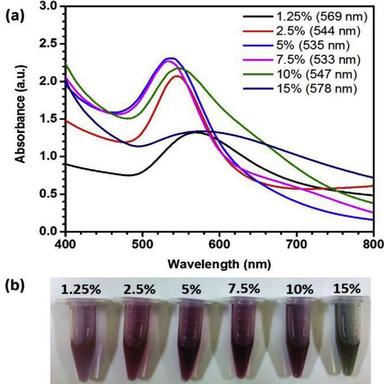
(a) UV–vis spectra of AuNPs synthesized at different concentrations of Lonicera japonica flower extract (1.25, 2.5, 5, 7.5, 10, and 15%, v/v) and (b) color changes after 2 min reaction incubation (from left to right: 1.25, 2.5, 5, 7.5, 10, and 15%, v/v). (For interpretation of the references to color in this figure legend, the reader is referred to the Web version of this article.)